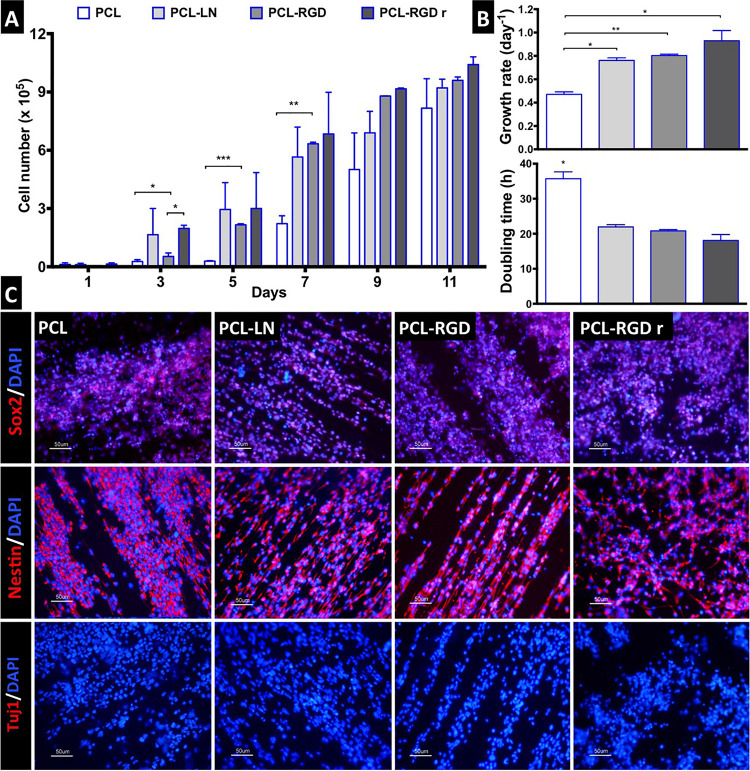
CGR8-NS growth profile on aligned PCL, PCL-LN, PCL-RGD, and random PCL-RGD nanofibers: (A) Cell number variation over 11 days of culture (n = 2); values correspond to initial cell seeding of 2.0 × 105 cells per scaffold. (B) Growth rates (day–1) and doubling times (h) for each condition; error bars are standard error of the mean; *p < 0.05, **p < 0.01, ***p < 0.001. (C) Fluorescence microscopy images of immunocytochemistry for Nestin, Sox2, and βIII–tubulin/Tuj1. Nuclei counterstained with DAPI; scale bar = 50 μm.